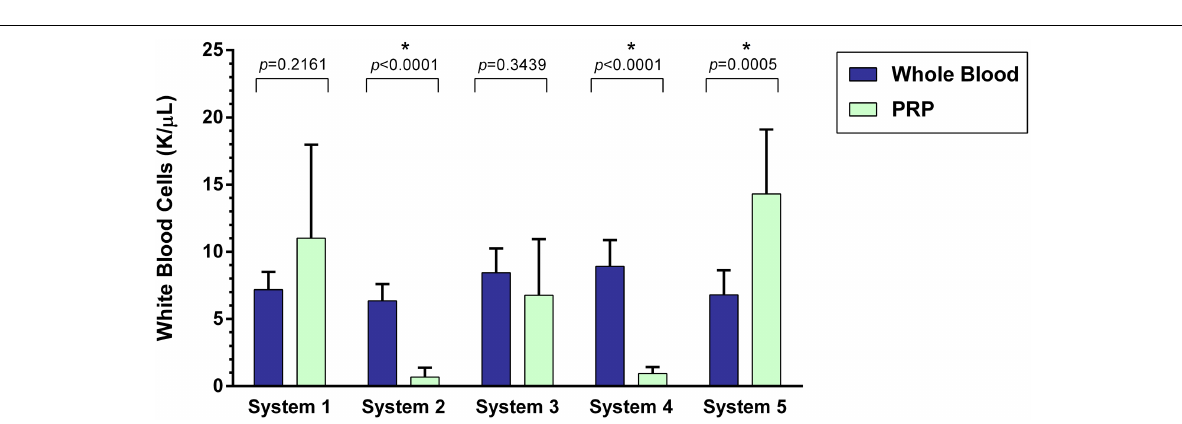
Fr ontiers in Veterinary Science |